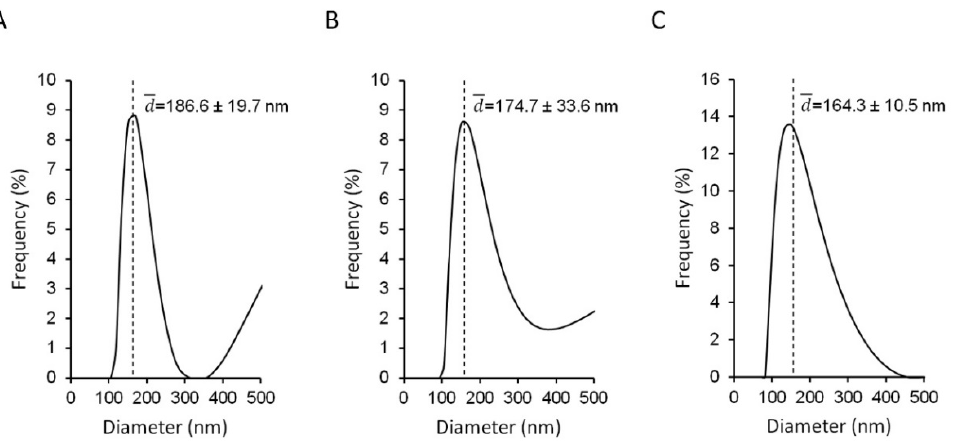
Figure 1. Size distributions and mean diameters of the different surface-charged AZT-liposomes (25 °C). ( A ), neutral (EL-AZT), ( B ), cationic (+EL-AZT) and ( C ), anionic ( − EL-AZT) liposomes with azithromycin (AZT). The corresponding PDI values were: 0.48 ± 0.02 ( A ), 0.45 ± 0.04 ( B ) and 0.36 ± 0.05 ( C ), respectively. Data are mean ± S.D ( n = 5).